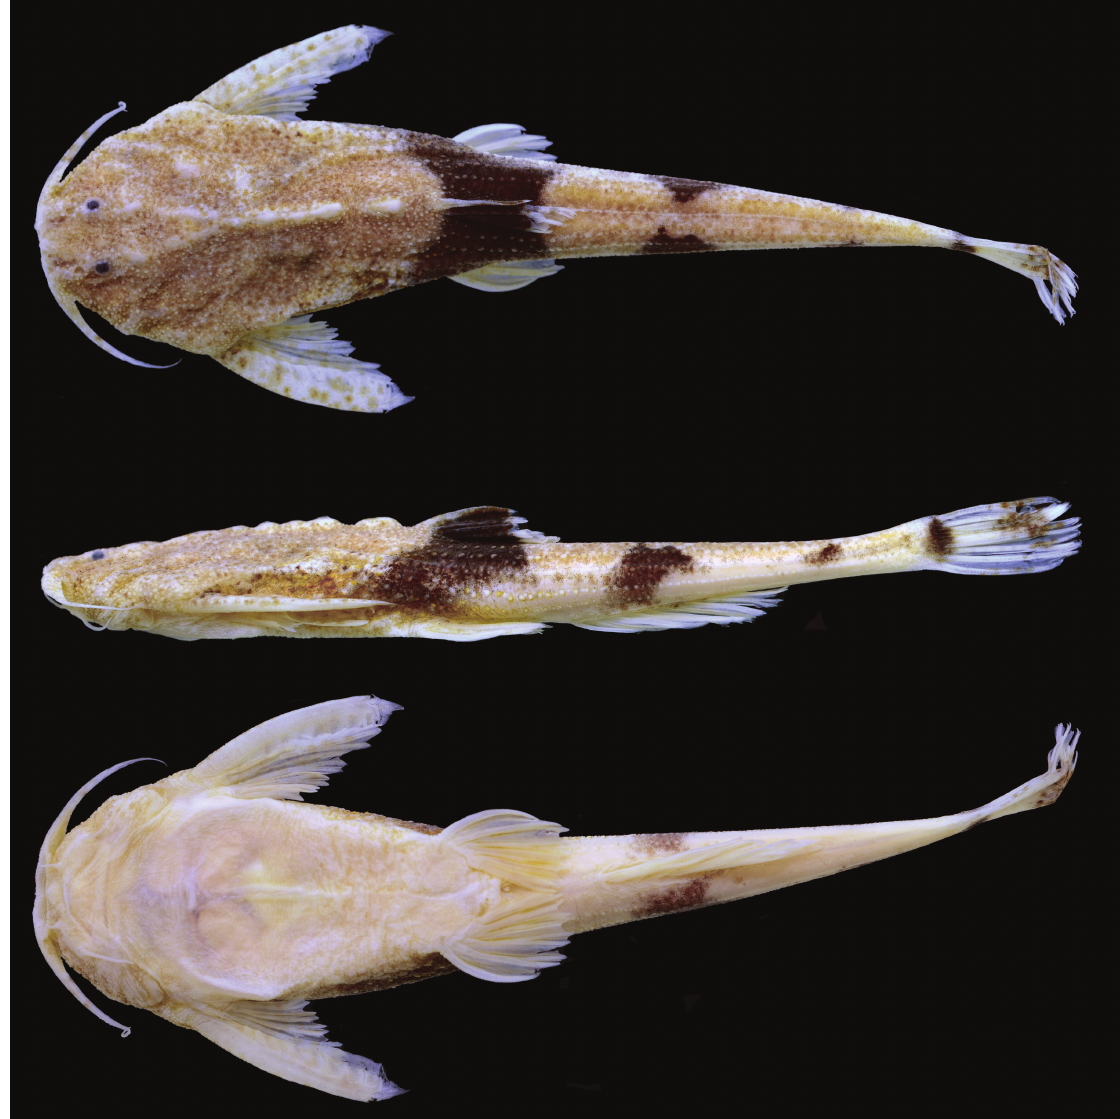
Fig. 1. Bunocephalus hartti , MZUSP 62745, holotype, 54.8 mm SL, rio Cipó at fazenda Duas Barras, Presidente Juscelino, Minas Gerais,